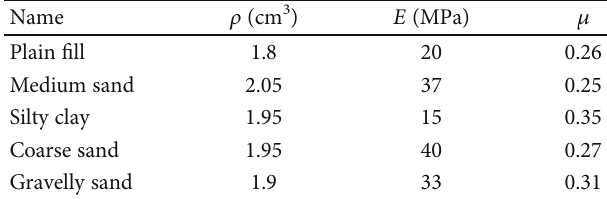
Table 9: Correlated parameters of the